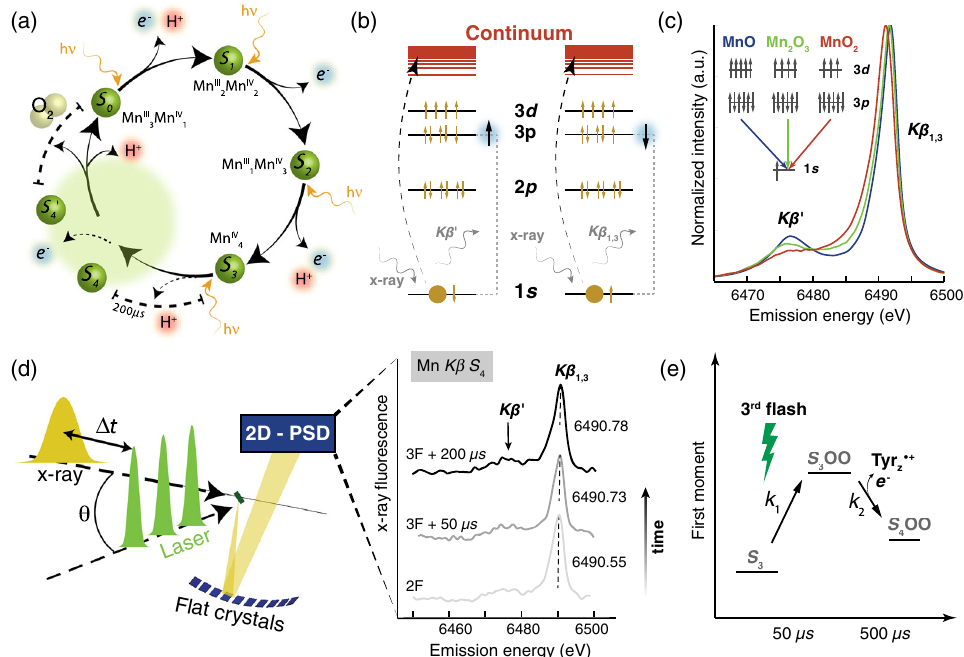
FIG. 1. (a) Current model of the Kok cycle. Depiction of sequential incident visible-light photon absorptions triggering electron or proton release [3]. The dashed region is based on previous analysis of the S 3 -to- S 0 transition in which the S 4 state is proposed [3,4]. (b) Electronic transitions, reflected in the K β main lines, are influenced by the spin state of the Mn ion. (c) A spectral comparison of Mn oxides depicts the effect of oxidation state on the K β emission lines. (d) Nanosecond laser pulses (1, 2, or 3) are used to advance the Kok cycle in the protein (Table S1 [5]). The pump-probe delay time Δ t , measured from the final laser flash to the center of the x-ray pulse, is set dependent on the desired S state. X-ray fluorescence from the sample is reflected by ten flat analyzer crystals onto a 2D-position- sensitive detector. K β emission spectra are extracted to form snapshots of the electronic structure in time. Smoothed emission spectra are presented for 2 F (majority S 3 ) and two time points during the S 3 -to- S 0 transition. (e) The proposed reaction scheme shows the early evolution of the OEC during the S 3 -to- S 0 transition, providing an interpretation of spectroscopic